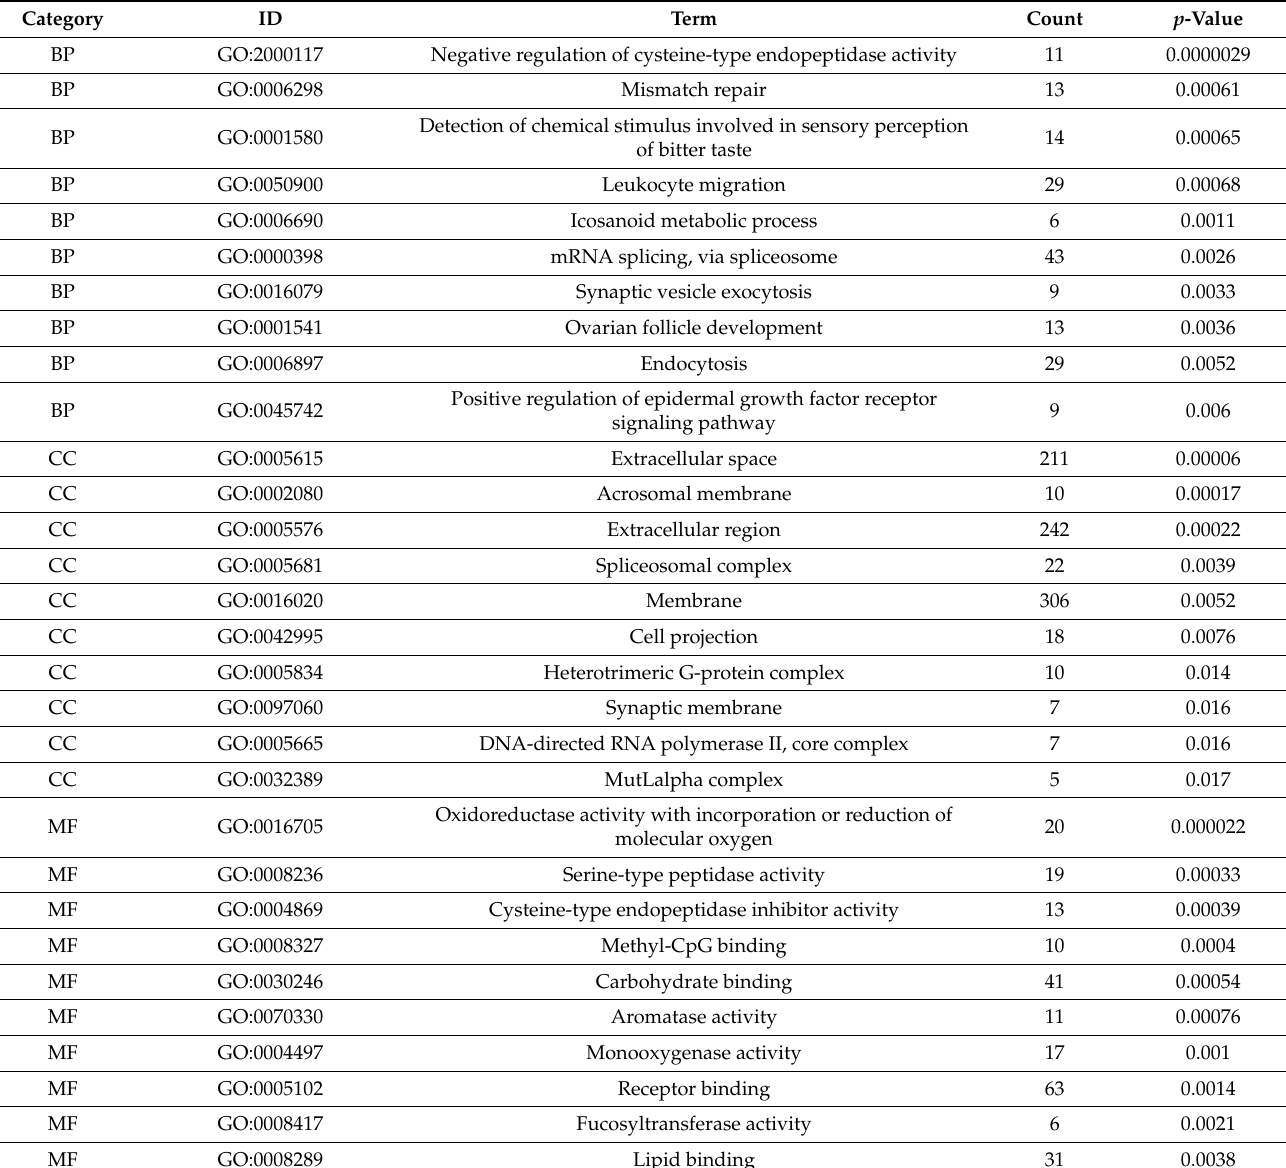
Table 5. Enrichment analysis of the GO and KEGG pathways of genes involved in